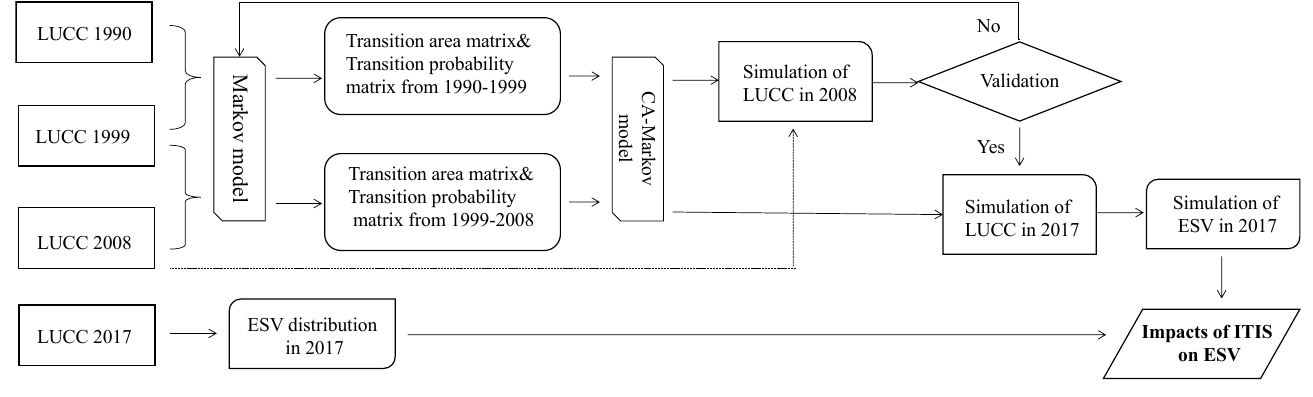
Figure 2. Technical roadmap.